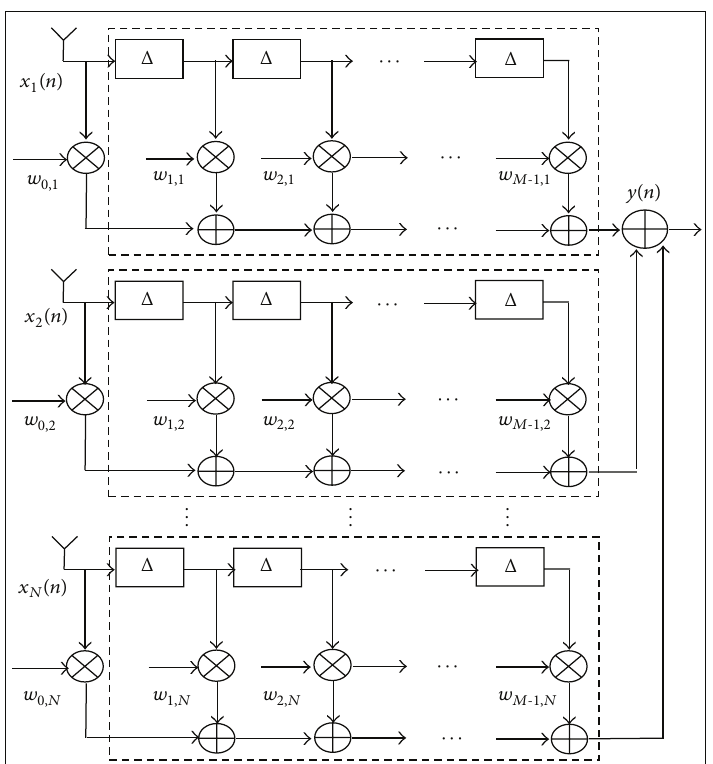
Figure 2: Block diagram of the